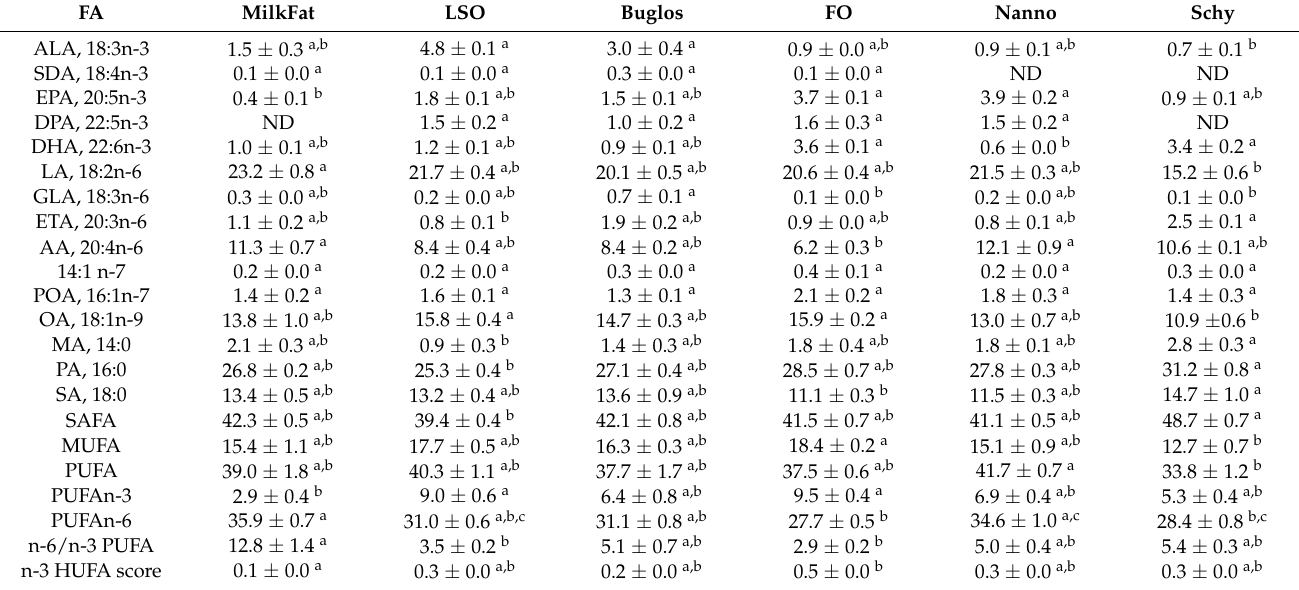
Data represent mean ± SEM for four rats per group and are expressed as % moles/total FA. Values in the same row with different superscript letters are significantly different, p ≤ 0.05 (one-way ANOVA nonparametric measures with Kruskal–Wallis test). ND, not